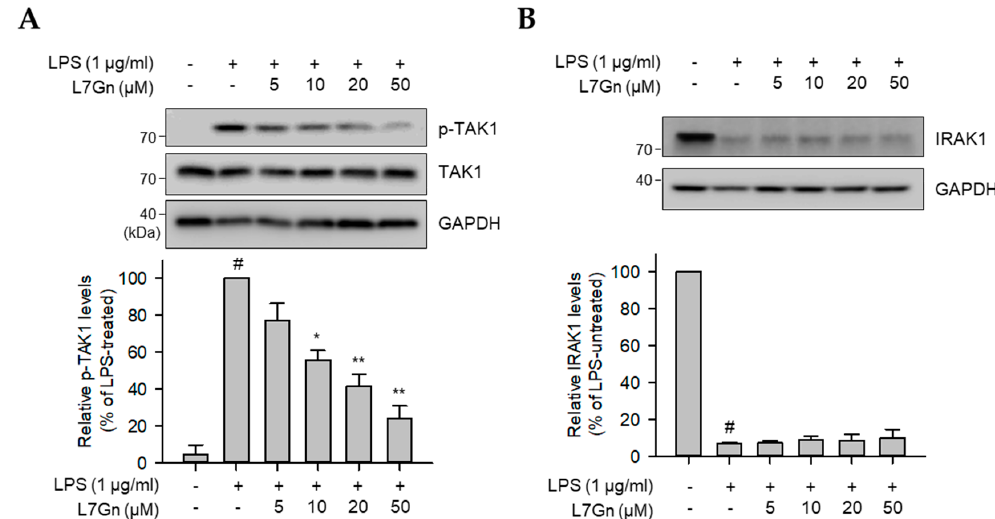
Figure 4. Effects of L7Gn on LPS-induced phosphorylation of TAK1 and degradation of IRAK1. RAW 264.7 cells were pre-treated with L7Gn for 2 h and then treated with LPS (1 µg/mL) for 3 min. Total proteins were subjected to immunoblot analysis using the indicated specific antibodies. ( A ) The level of phosphorylated TAK1 was normalized to that of total TAK1. ( B ) The expression of IRAK1 was normalized to that of GAPDH. Results of the quantitative analyses of phosphorylated or total protein levels after normalization are shown (lower panel). Data represent the mean ± S.D. # p < 0.01 relative to the LPS-untreated control group. # p < 0.01 relative to the LPS-untreated control group. * p < 0.05 and ** p < 0.01 relative to the LPS-treated and 5 µM L7Gn-treated group.